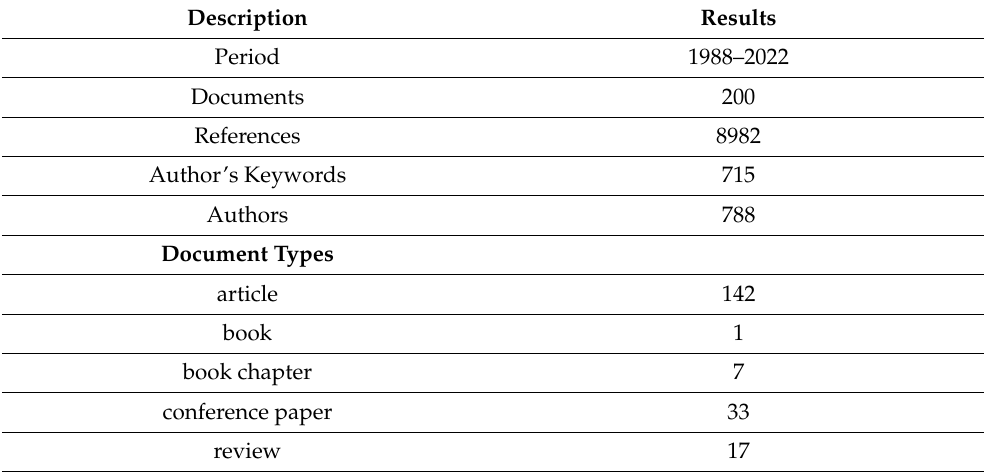
Table 1. Main information regarding the